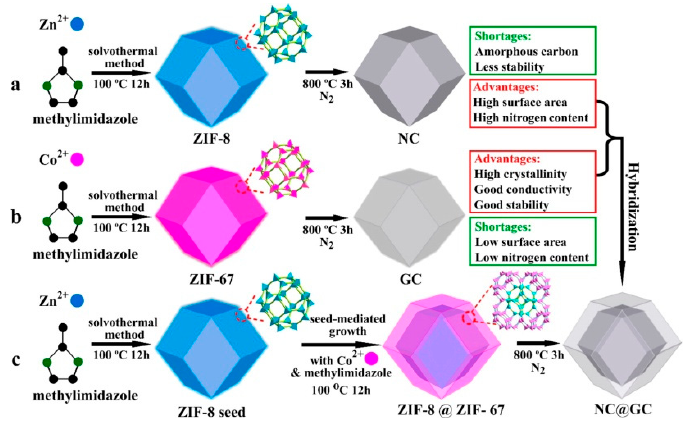
Figure 10. Preparation steps for ( a ) ZIF-8 crystals and NC, ( b ) ZIF-67 crystals and GC, and ( c ) core/shell ZIF-8@ZIF-67 crystals and NC@GC [141].